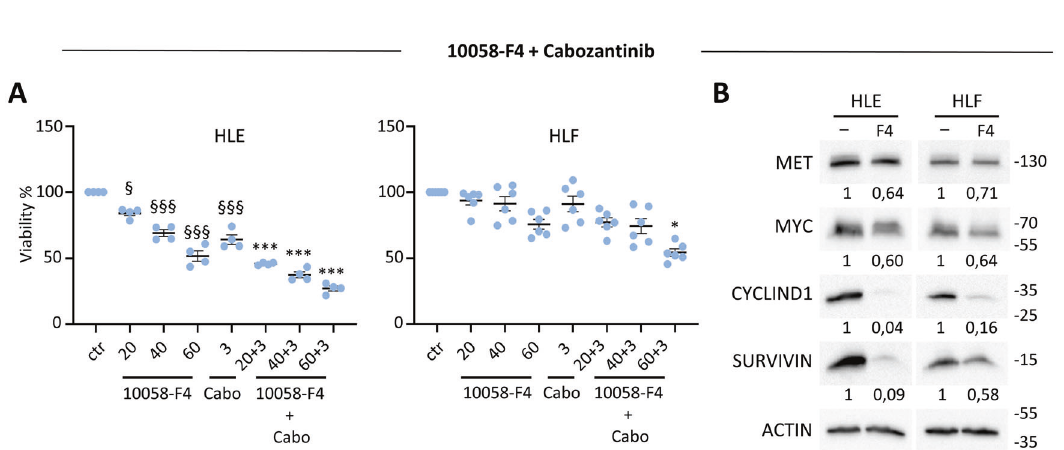
Fig. 6 MYC targeting confers responsiveness of a subset of HCC cell lines to cabozantinib treatment. A Western blot reporting expression and phosphorylation levels of the indicated proteins in a panel of human HCC cell lines. ACTIN and TUBULIN were used for normalisation (full blots of gels are reported in Figs. S6 and S7). B Graphs reporting quanti fi cations of expression of the indicated proteins, based on densitometric analysis by Image J. Measures were normalised using ACTIN or TUBULIN; the quanti fi cation was done setting as 1 the expression of the cell line with the lowest amount of protein. * p < 0.05. C Graphs reporting cell viability assays performed using 10058-F4 (20, 40, and 60 µM) either alone or with cabozantinib (3 µM) in the indicated human HCC cell lines. With 10058-F4 (40 µM), reduced viability to: 83.24% in JHH5, p > 0.05; 43.33% in Hep3B, p < 0.0001; 80.68% in Huh7, p < 0.001. With cabozantinib, reduced viability to: 72.87% in JHH5, p > 0.05; 64.58% in Hep3B, p < 0.0001; 75.74% in Huh7, p < 0.0001. With 10058-F4 + cabozantinib, reduced viability to: 23.60% in JHH5, p < 0.01; 23.83% in Hep3B, p < 0.001; 40.15% in Huh7, p < 0.0001. D Graphs reporting cell viability assays performed using Omomyc (10 and 30 µM) either alone or with cabozantinib (3 µM) in the indicated human HCC cell lines. With Omomyc, reduced viability to: 74.03% and 39.94% in Hep3B cells with 10 and 30 µM, p < 0.01 and p < 0.0001, respectively. With Omomyc + cabozantinib, reduced viability to: 54.11% and 41.50% in JHH5 cells with 10 and 30 µM, p > 0.05 and p < 0.01; 35.31% and 12.12% in Hep3B cells with 10 and 30 µM, p < 0.05 and p < 0.01; 59.13% and 39.84% in Huh7 cells with 10 and 30 µM, p > 0.05 and p < 0.001). In C and D , three to six independent experiments were done. E , F Western blots reporting the expression levels of the indicated proteins in human HCC cells untreated and treated with 10058-F4 (60 µM; E ) or with Omomyc (30 µM; F ). Note a consistent downregulation of SURVIVIN, CYCLIN D1, and MYC levels in the analysed cell lines exposed to either Omomyc or 10058-F4. Unchanged or slight downregulation of MET levels was observed following MYC blockage, coherent with the sensitivity of cells to MET inhibition by cabozantinib shown in panels ( C ) and ( D ). Statistical analyses were performed by (one-way) ANOVA. § p < 0.05; §§ p < 0.01; §§§ p < 0.001; * p < 0.05; ** p < 0.01; *** p < 0.001. § indicates 10058-F4 or Omomyc and cabozantinib (cabo) versus controls (ctr); *